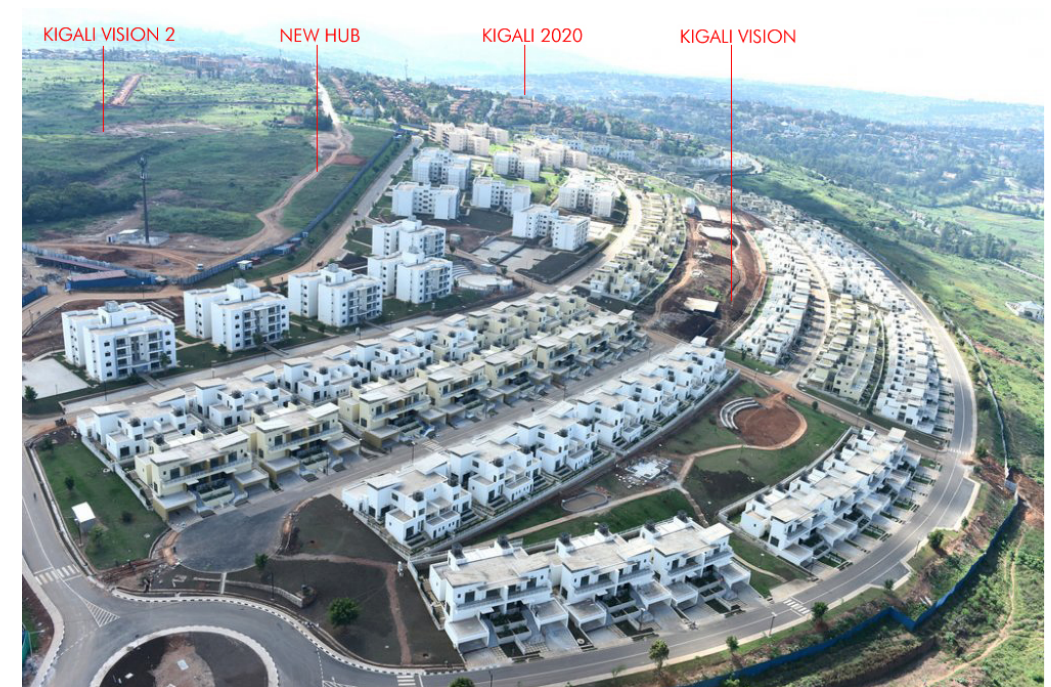
Figure 4. Existing and future developments of Gacuriro Satellite, adapted from Umucunguzi (2018). voyage in space and time, but always gravitating around one specific idea, the Trabantestadt . The central nucleus can be Breslau or Mombasa, Frankfurt or Kigali, what is adapting to the context is the urban design structure of the single satellite.